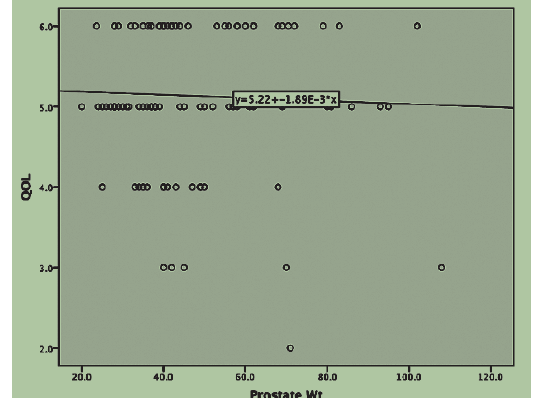
Figure 6. Scatter diagram showing correlation between QOL and Wt of